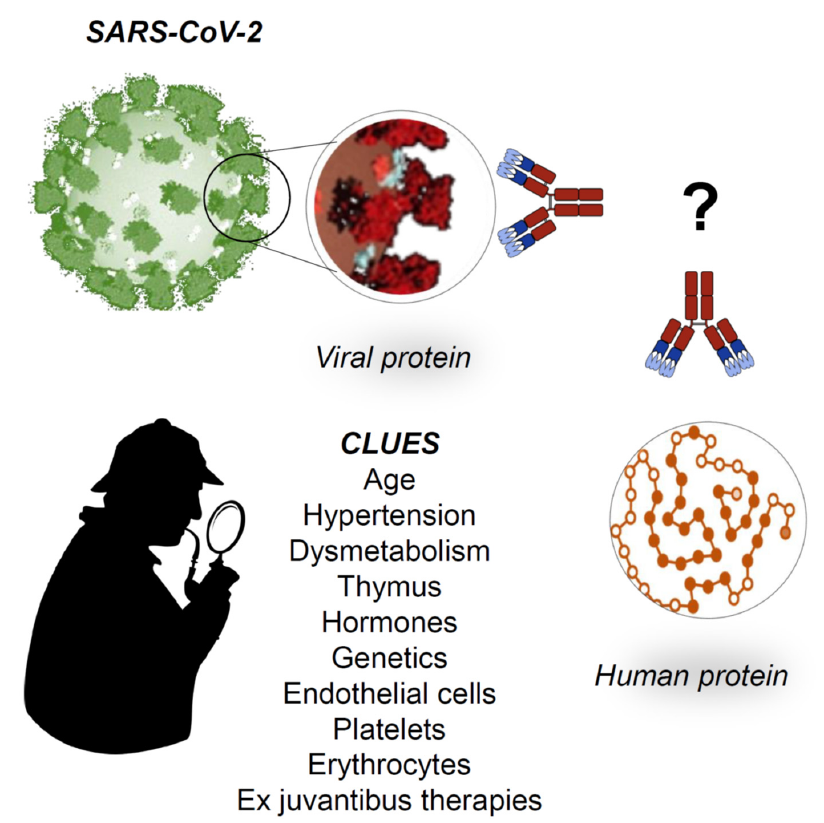
Figure 4. Working hypotheses. The establishment of generalized signs and symptoms of immune system activation indicates a serious aggravation of the COVID-19, which may be irreversible without proper medical intervention. Even with prompt medical intervention, the disease may follow its course and cause death. At the moment, there is no specific therapy for COVID-19, but clinicians use ex juvantibus therapy based on anti-inflammatory drugs such as tocilizumab (that inhibits IL6) and hydroxychloroquine (inhibits IL-1 and TNF-alfa); it is noteworthy that both drugs are used with success in autoimmune diseases. We hypothesize that, at the basis of the generalized activation of the immune system, there are molecular mimicry phenomena: the antibodies produced against the virus could turn into autoantibodies against crossreactive proteins expressed on human cells, causing autoimmunity with cell destruction. What proteins? Which cells? What are the predisposing factors? Furthermore, can there be protective factors? All of these are open questions now, although there are several clues that show directions for research in the immediate